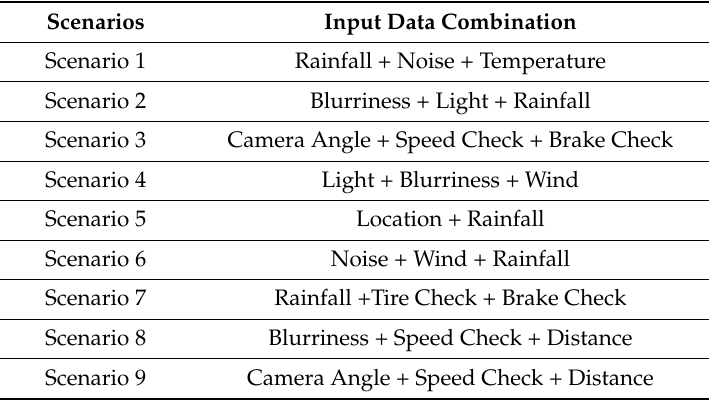
Table 8. Input data